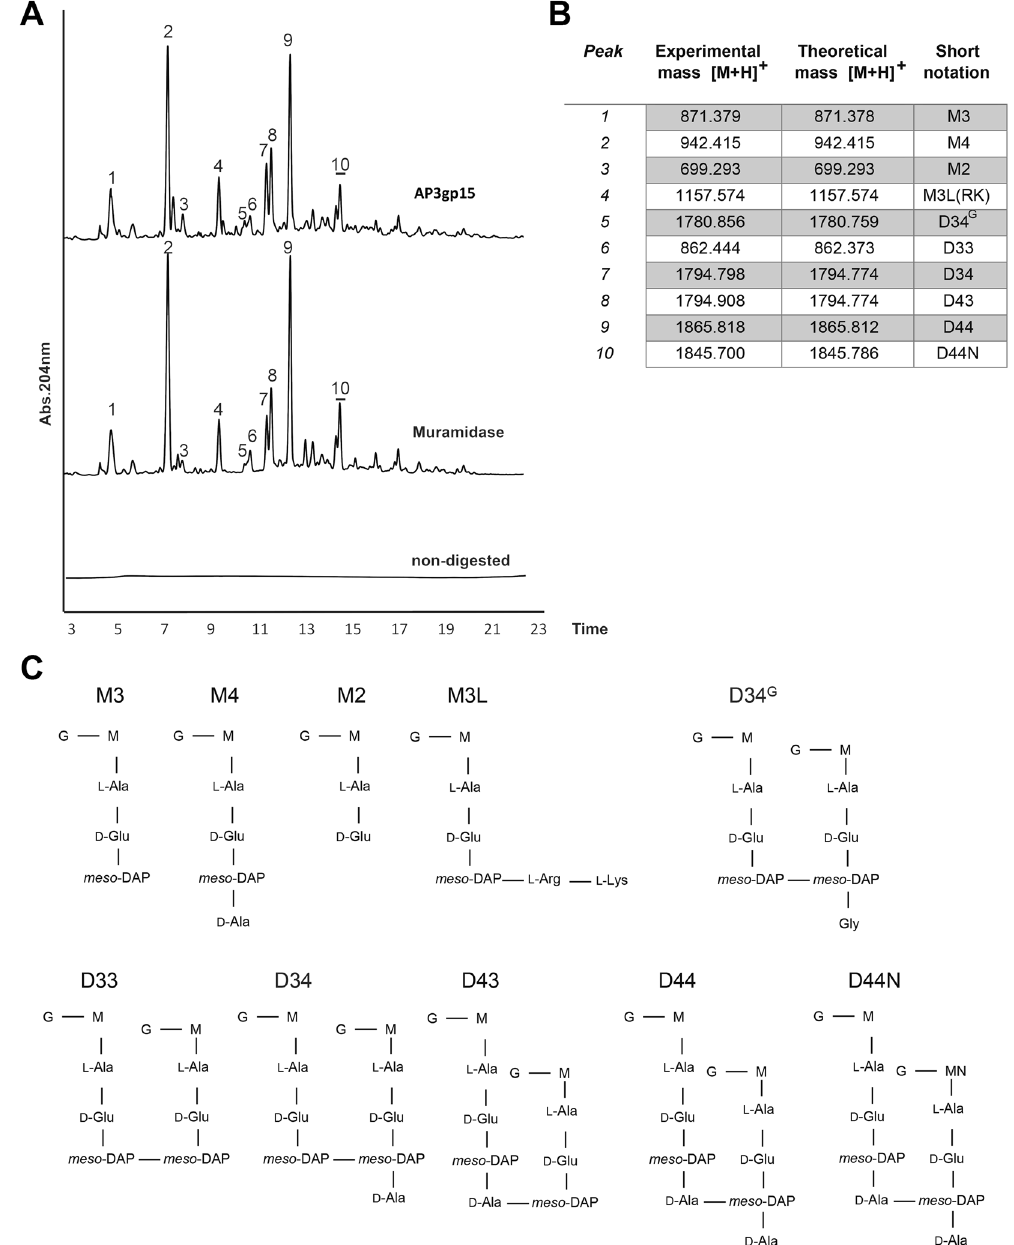
Figure 5. Cleavage specificity of AP3gp15. ( A ) UPLC chromatogram of in vitro digestion of E . coli sacculus either with muramidase, AP3gp15 or without enzyme (non-digested). ( B ) Mass spectrometry muropeptide analysis. M2 , N-acetylglucosamine-(Glc N Ac)-N-acetylmuramic acid (Mur N Ac)-l-Ala-d-Glu; M3 , Glc N Ac- Mur N Ac-l-Ala-d-Glu-meso-DAP; M4 , GlcNac-Mur N Ac-l-Ala-d-Glu-meso-DAP-d-Ala; M3L , Glc N Ac- Mur N Ac-l-Ala-d-Glu-meso-DAP-Arg-Lys, oligopeptide from Braun’s lipoprotein which remains bound to the muropeptide after cleavage by Pronase E; D33 , dimer muropeptide of a M3 cross-linked with a M3; D34 , dimer muropeptide of a M3 l,d-cross-linked with a M4; D34 G , dimer muropeptide of a M3 cross-linked with a M3 G (Glc N Ac-Mur N ac-l-Ala-d-Glu-meso-DAP-Gly); D43 , dimer muropeptide of a M4 d,d-cross-linked to a M3; D44 , dimer muropeptide of a M4 cross-linked with a M4; D44N , dimer muropeptide of a M4 cross-linked with a M4N (anhydrous in the Mur N